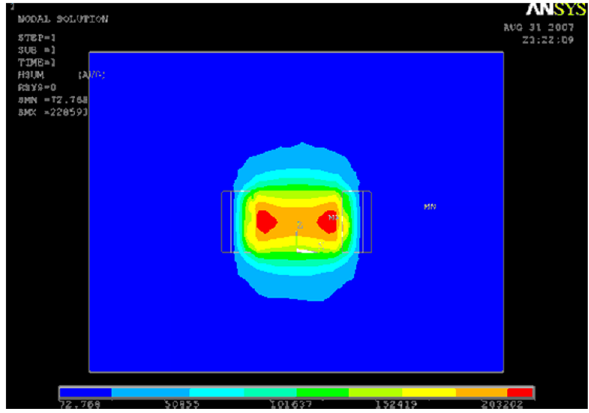
Figure 4: Simulation of the magnetic fi eld strength of the